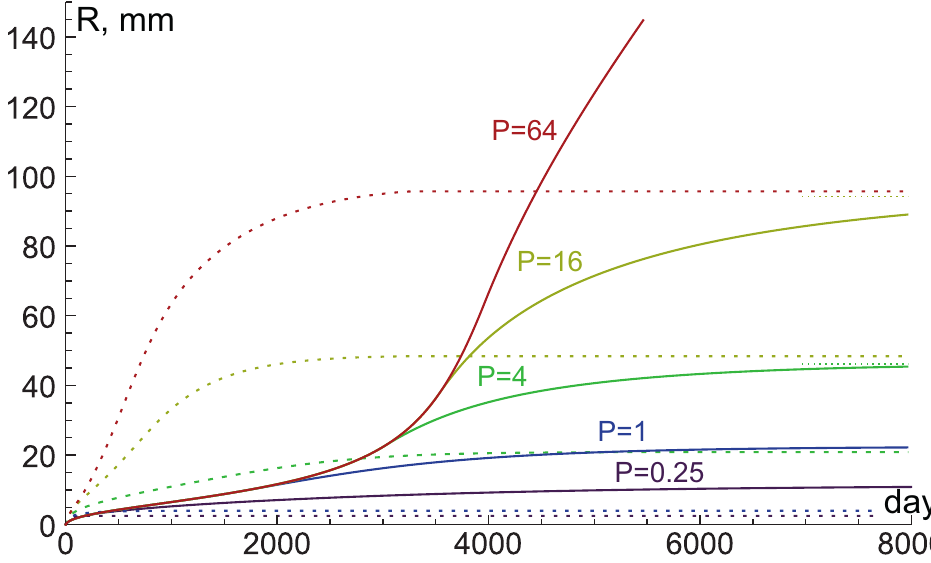
Figure 11. Tumor growth curves, produced by numerical simulations of the system of Equation (6) under different nutrient supply levels P and tissue hydraulic conductivity K / µ = 0.003 (solid lines) and K / µ = 0.03 (dashed lines). Dotted lines denote the limit values of tumor radii under K / µ = 0.003 and P = 4, P = 16. The simulation under K / µ = 0.003 and P = 64 was stopped at R = 300 mm, before approaching stationary